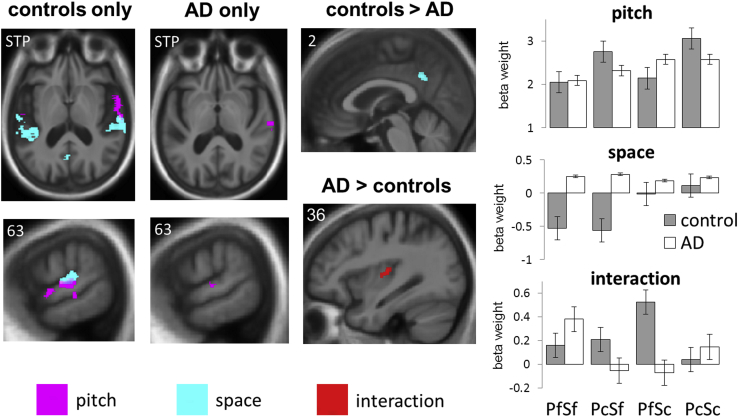
Functional neuroanatomical substrates for the analysis of spatial sounds and the effect of Alzheimer's disease (AD). Statistical parametric maps show all significant regional brain activations identified within the healthy control group (far left panels), the AD group (middle left panels), and in group comparisons (middle right panels); maps have been rendered on representative axial (top left) and sagittal sections of the study-specific group mean T1-weighted structural MR image. The MNI coordinate of each section plane is indicated (the axial section is tilted to display auditory cortical areas in the superior temporal plane (STP); the right hemisphere is shown on the right). Maps have been thresholded at p < 0.001 uncorrected for multiple comparisons over the whole brain, showing clusters >50 voxels, for display purposes; for healthy controls and group comparisons, clusters shown were also significant at threshold p < 0.05 after correction for multiple comparisons within prespecified anatomical regions of interest (see also Table 2 and Table S3). Contrasts were composed as follows: pitch variation (pitch − magenta), [(PcSc + PcSf) − (PfSc + PfSf)]; spatial variation (space − cyan), [(PcSc + PfSc) − (PcSf + PfSf)]; spatial-pitch interaction (interaction, red), [(PcSc–PcSf) − (PfSc − PfSf)]. Also shown (far right panels) are plots of beta weights (group mean ±1 standard error beta parameter estimates) at the peak voxel for the pitch variation contrast in the healthy control group (in anterior superior temporal cortex, top; not significant at the prescribed corrected threshold in the AD group), and for significant group comparisons in the spatial variation contrast (healthy control group greater than AD group in posterior cingulate cortex, middle) and the spatial-pitch interaction contrast (AD group greater than control group in posterior insula, below). Abbreviations: PcSc, pitch changing, spatial location changing; PcSf, pitch changing, spatial location fixed; PfSc, pitch fixed, spatial location changing; PfSf, pitch fixed, spatial location fixed. (For interpretation of the references to color in this figure legend, the reader is referred to the Web version of this article.)